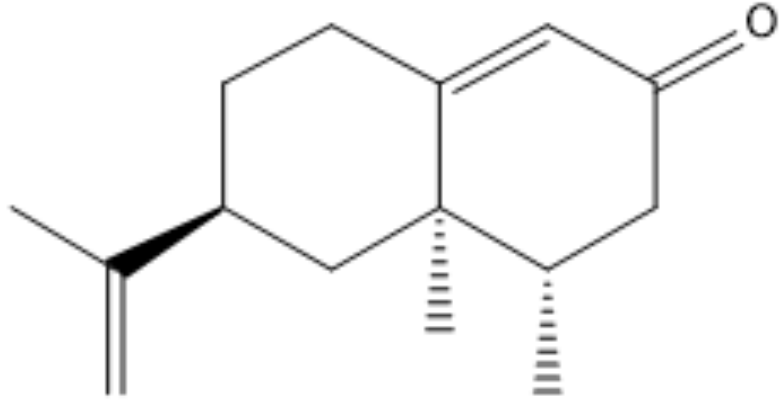
Figure 1. The image of nootkatone’s chemical structure.